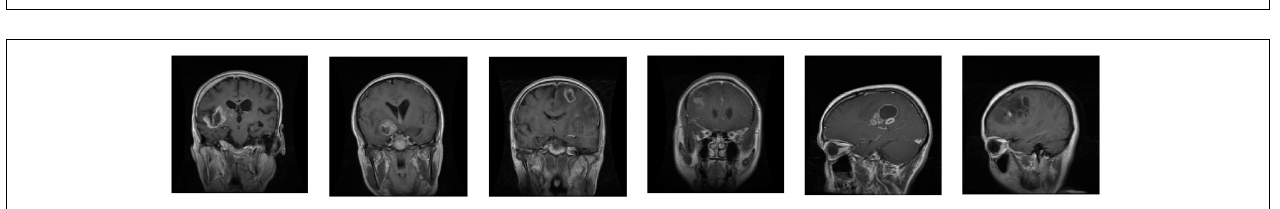
FIGURE 2 | Retrieval result examples of SRDML in Meningioma.